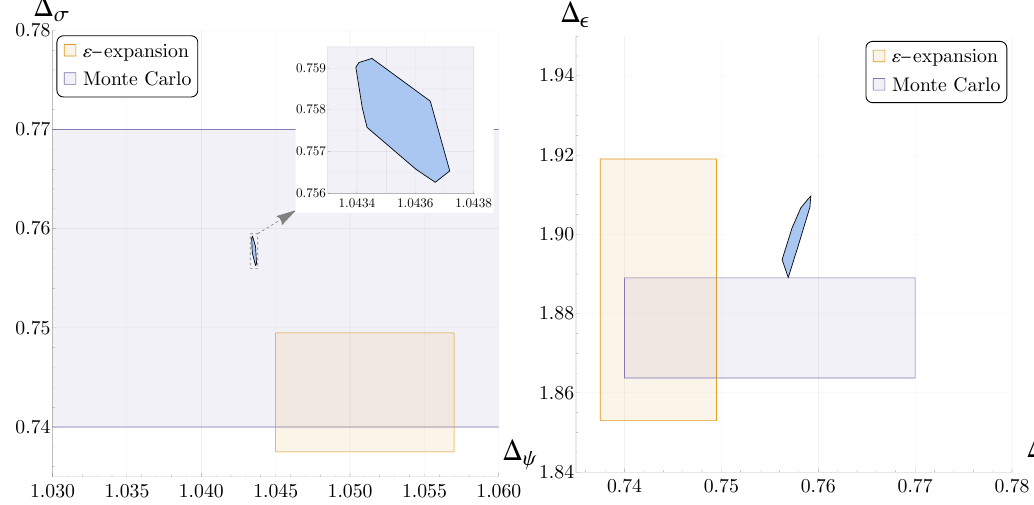
Figure 6 . The allowed region for the N = 4 critical GNY model when imposing that ∆ σ 0 > 3 computed at n = 18 , projected to the (∆ ∆ ) and (∆ ∆ ) planes. This should be compared max ψ , σ σ , (cid:15) to the Borel re-summed result obtained from the (cid:15) -expansion [31] obtained using the DREG regularization scheme (shown in orange) and with the Monte Carlo results from [40] (shown in purple). Results for ∆ are not available from the Monte Carlo study ψ